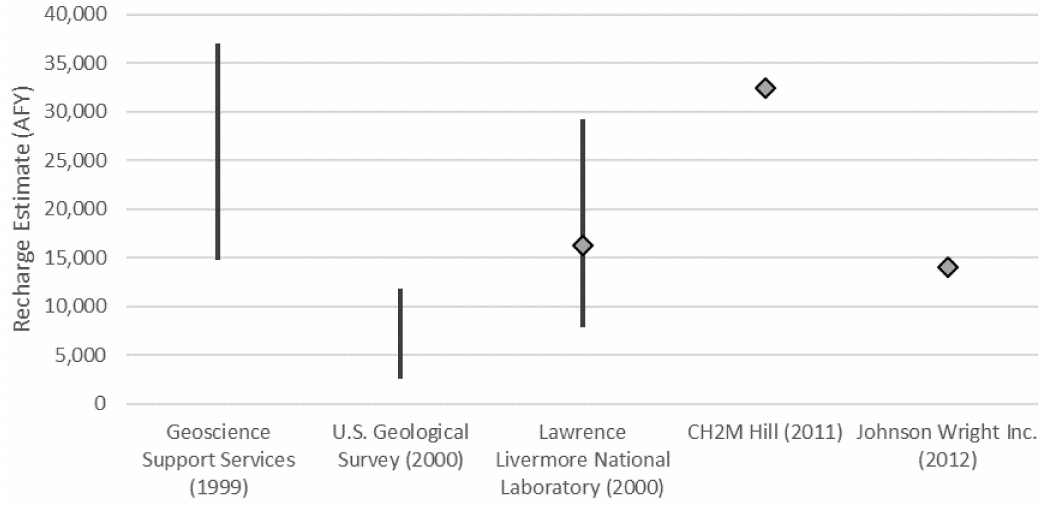
Figure 6. Comparison of the recharge estimates in the region of each of the previous studies